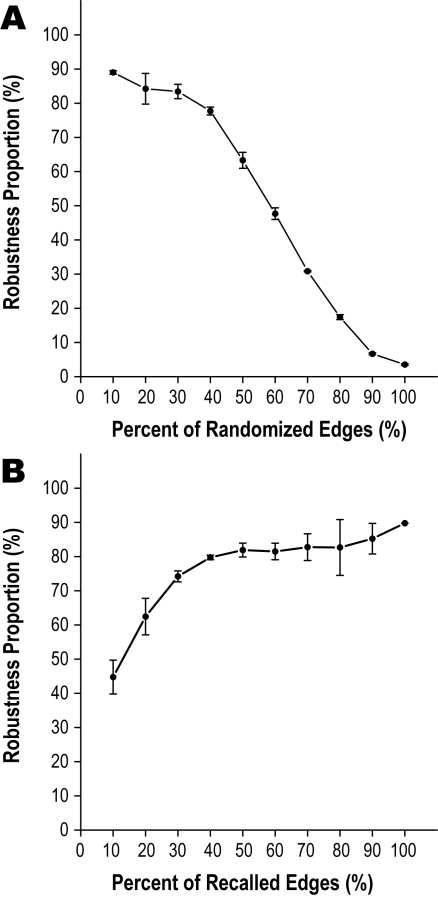
Influence of accuracy and number of edges in the gene networks on tree building.The template tree was based on the consensus tree in Figure 2 in both panels. The robustness proportions for template tree were constructed from 100 replicates of the networks generated in edge randomize simulation (up) or edge recall simulation (down). The data point and error bar represent the mean value of average robustness proportions in all template tree forks and plus/minus one standard error of 3 replicates. (A) Edge randomize simulation. The original gene networks are randomized by step of 10% from 10% to 100%. The result indicates that randomized gene relationship networks lead to unstable phylogenetic tree. (B) Edge recall simulation. The original gene networks are recalled by step of 10% from 10% to 100% too. The trend shown here indicates the growing amount of gene relationships or function information can improve the robustness of the resulting tree. With this result, the functional genomic research, such as protein-protein interaction analysis, can be helpful to resolve the universal tree of life.